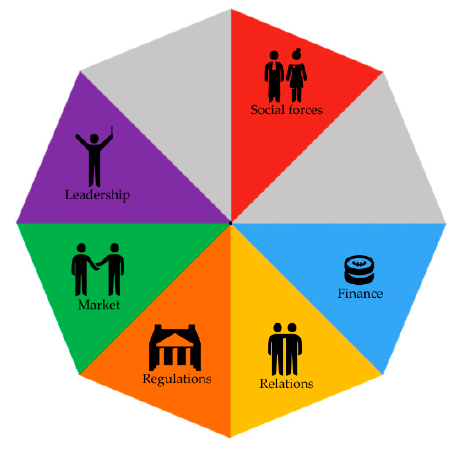
Figure 6. Creating a reason to commit.